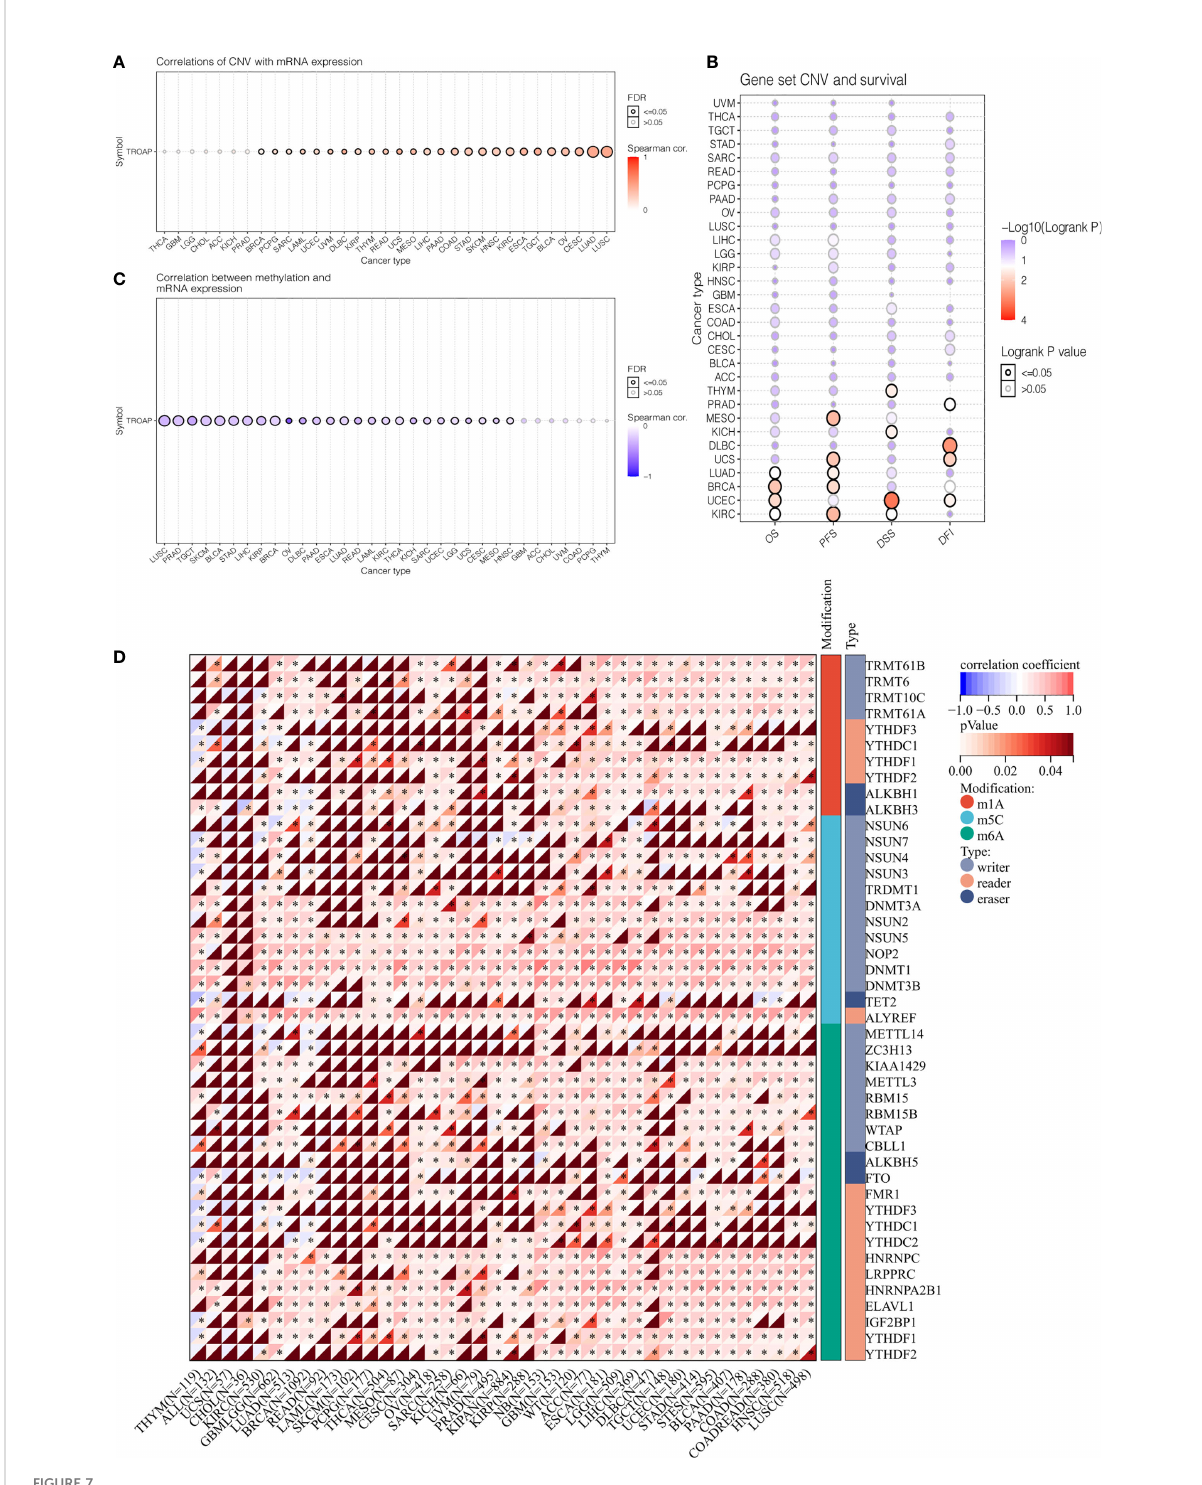
FIGURE 7 The correlation of TROAP transcriptional expression and its post-transcriptional modi fi cation in pan-cancer. (A) The association of TROAP expression and copy number variation (CNV). (B) The association between TROAP gene set CNV and survival possibility in 31 cancer types. (C) The correlation between TROAP expression and gene promoter methylation. (D) The correlation between TROAP expression and the gene markers of three classes of RNA modi fi ed patterns (m1A, m5C, and m6A). All *: P <